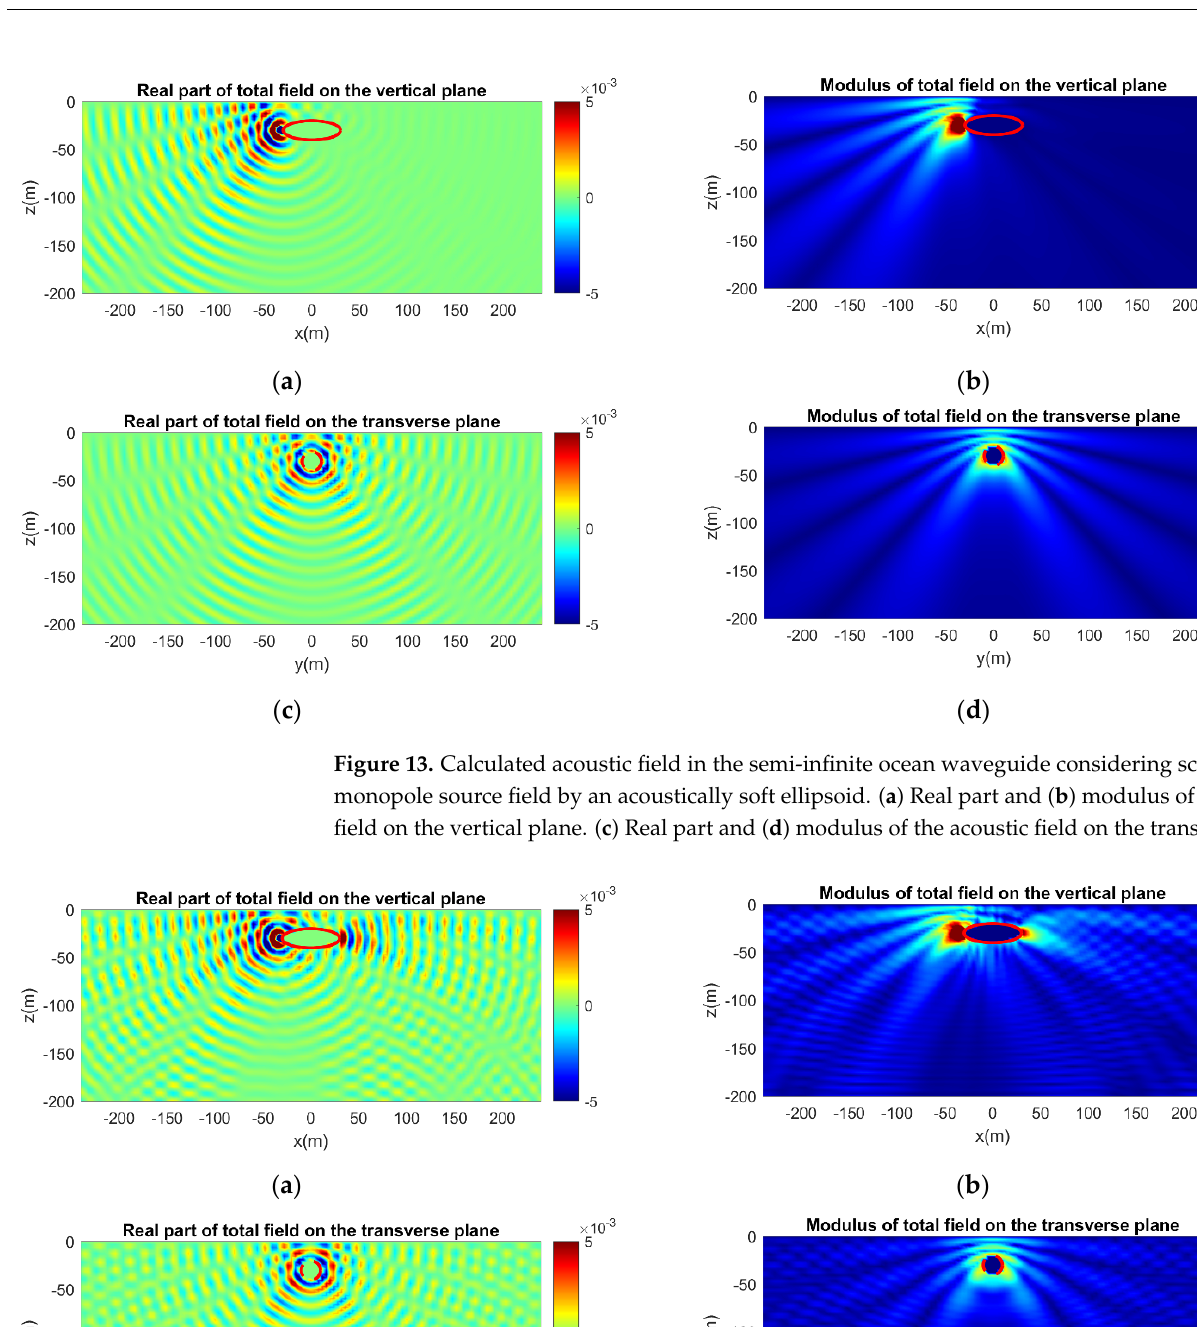
Figure 12. Same as Figures 10 and 11, but for a vertical dipole source. The axis of the dipole is parallel to the z-axis. ( a ) Real part and ( b ) modulus of the acoustic field on the vertical plane. ( c ) Real part and ( d ) modulus of the acoustic field on the transverse plane.